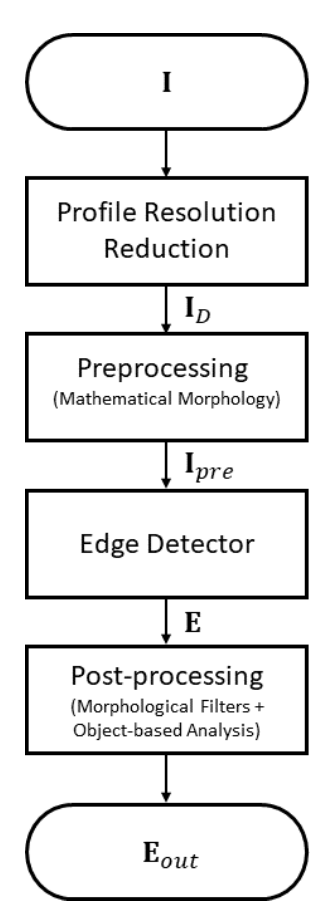
Figure 1. The flowchart of the MIPA algorithm.